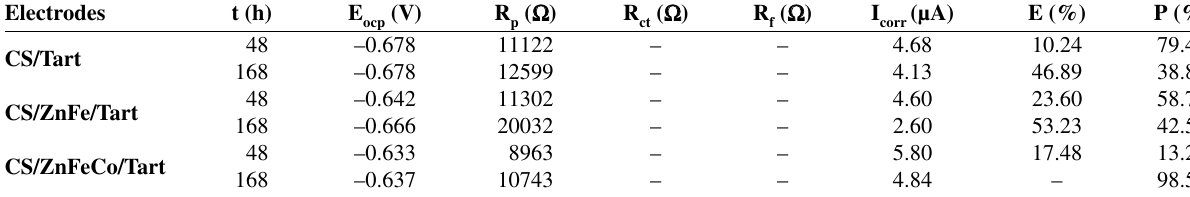
Table 3. Impedance data obtained by simulation of Fig. 8. β